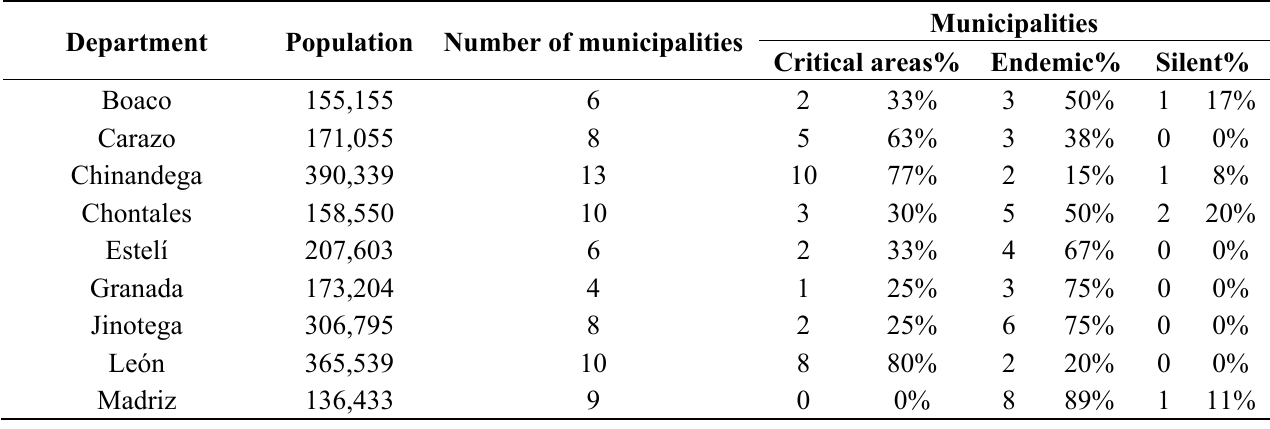
Table 3. Population, number of municipalities, risk stratification, by department, Nicaragua,